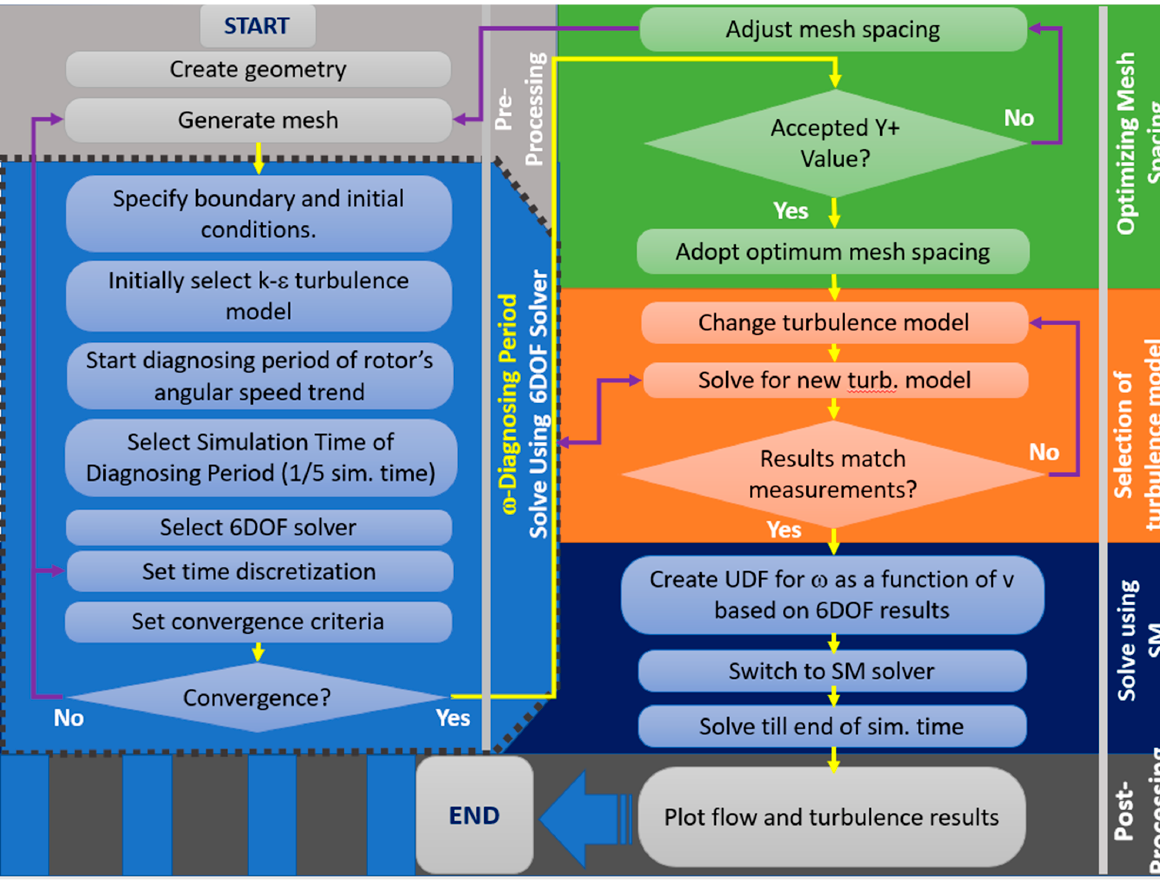
Figure 5. Block diagram for the adopted CFD workflow.